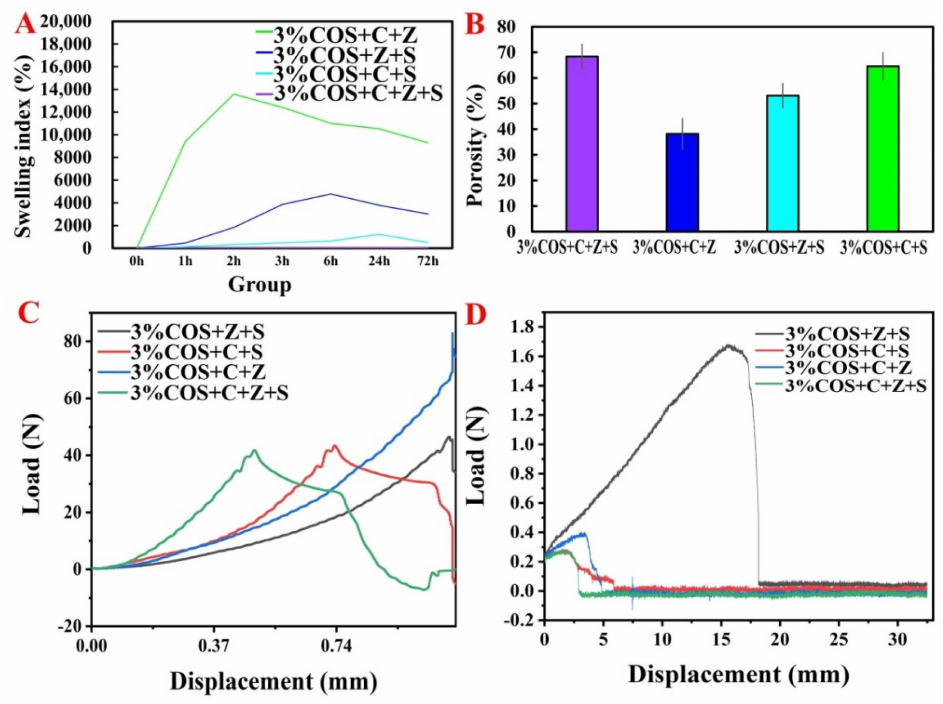
Figure 2. Physical properties of nIon 2+ − COS/SA gel films. ( A ) Dissolution rate of nIon 2+ − COS/SA gel films. ( B ) Porosity of nIon 2+ − COS/SA gel films. ( C ) Tensile strength and deformation curves of nIon 2+ − COS/SA gel films. ( D ) Fracture strength of nIon 2+ − COS/SA gel